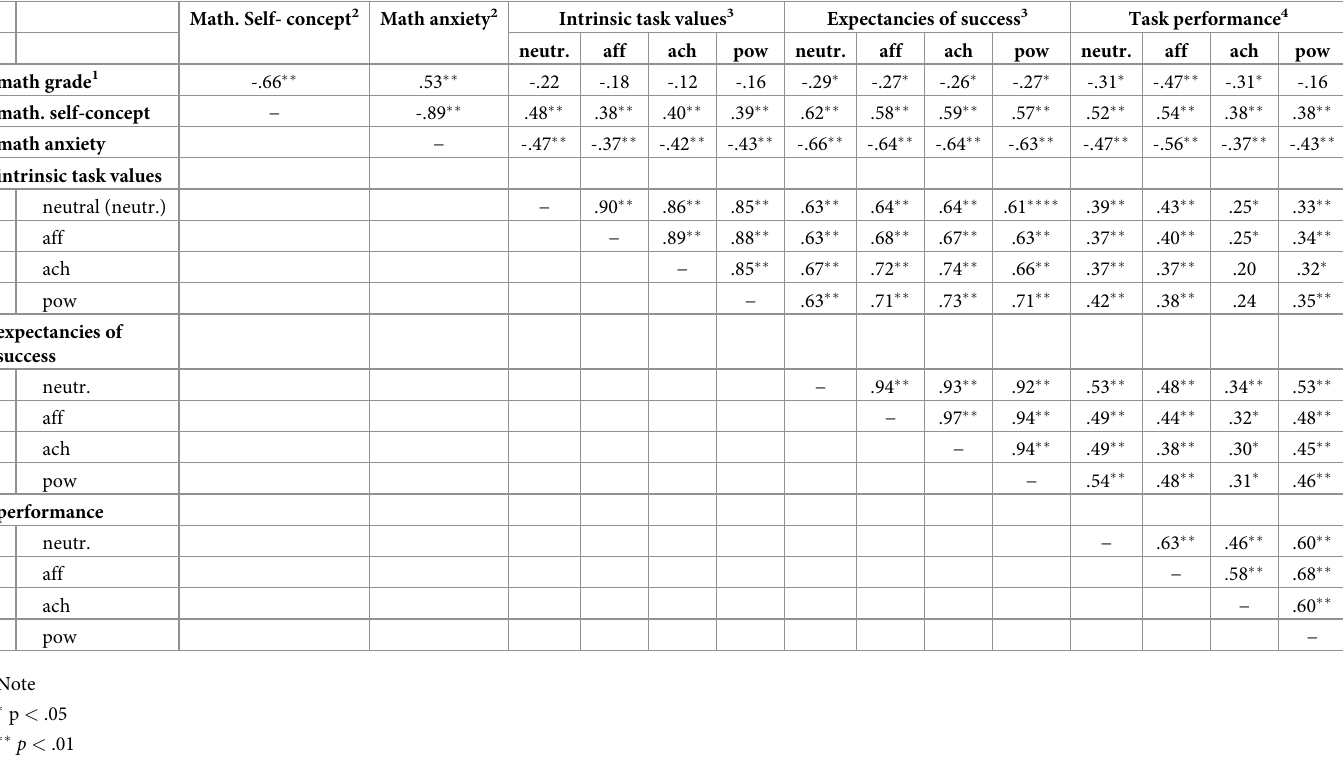
Table 6. Intercorrelations for students’ math grades in high school, math-related self-concept, math anxiety, with intrinsic task values, expectancies of success and performance in neutral tasks and tasks related to affiliation, achievement, and power in Experiment 3. Math. Self- concept 2 Math anxiety